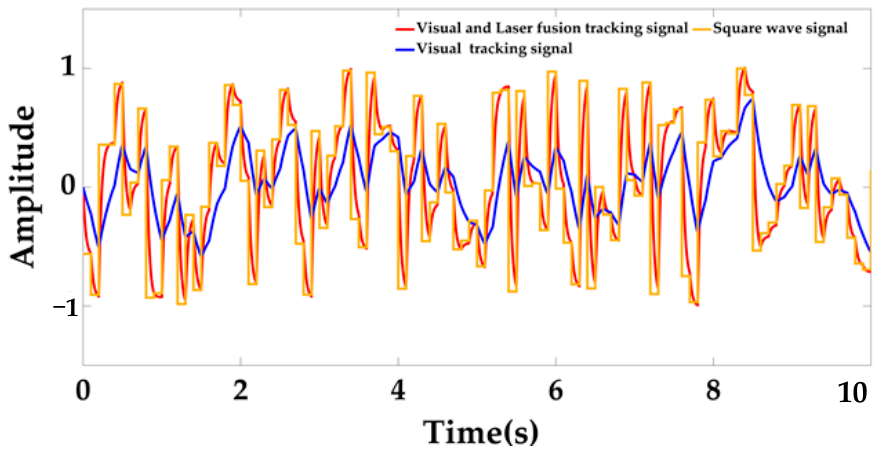
Figure 15. Comparison diagram of tracking effect.